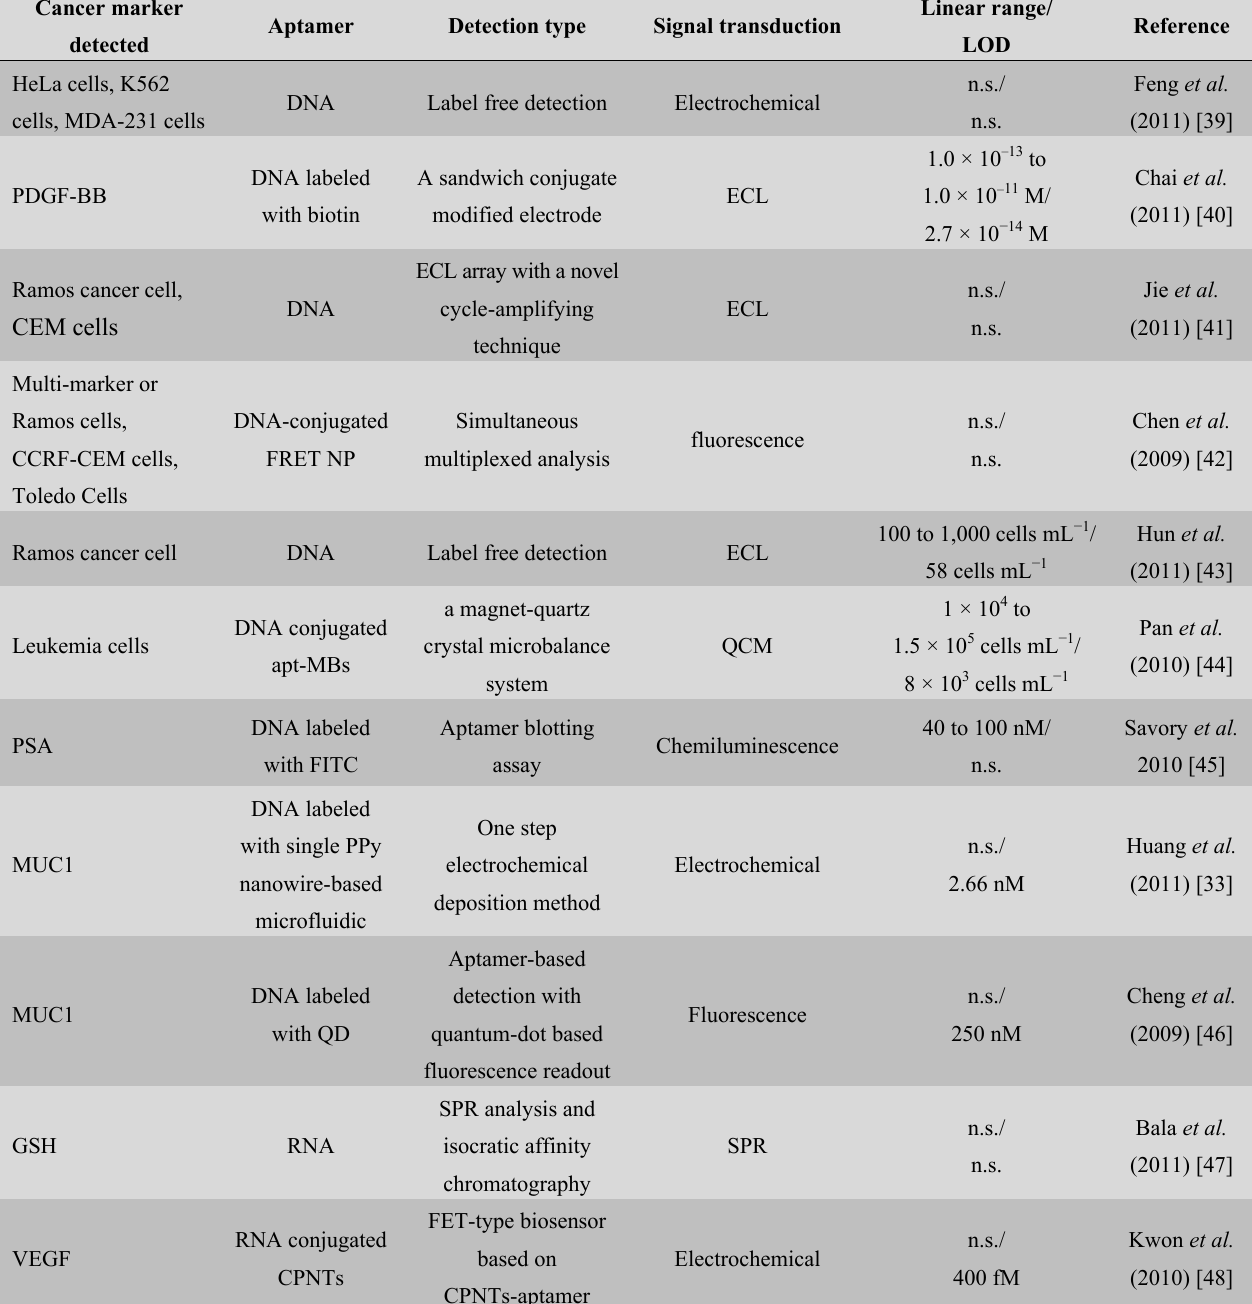
Table 2. Examples of application of aptasensors for cancer clinical